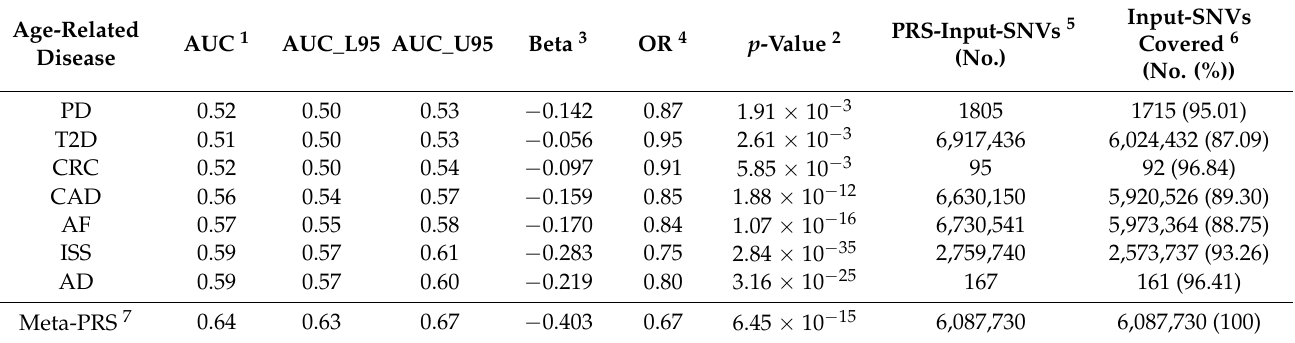
Table 1. Accuracy statistics for the calculation of each ARD-PRS in the German study